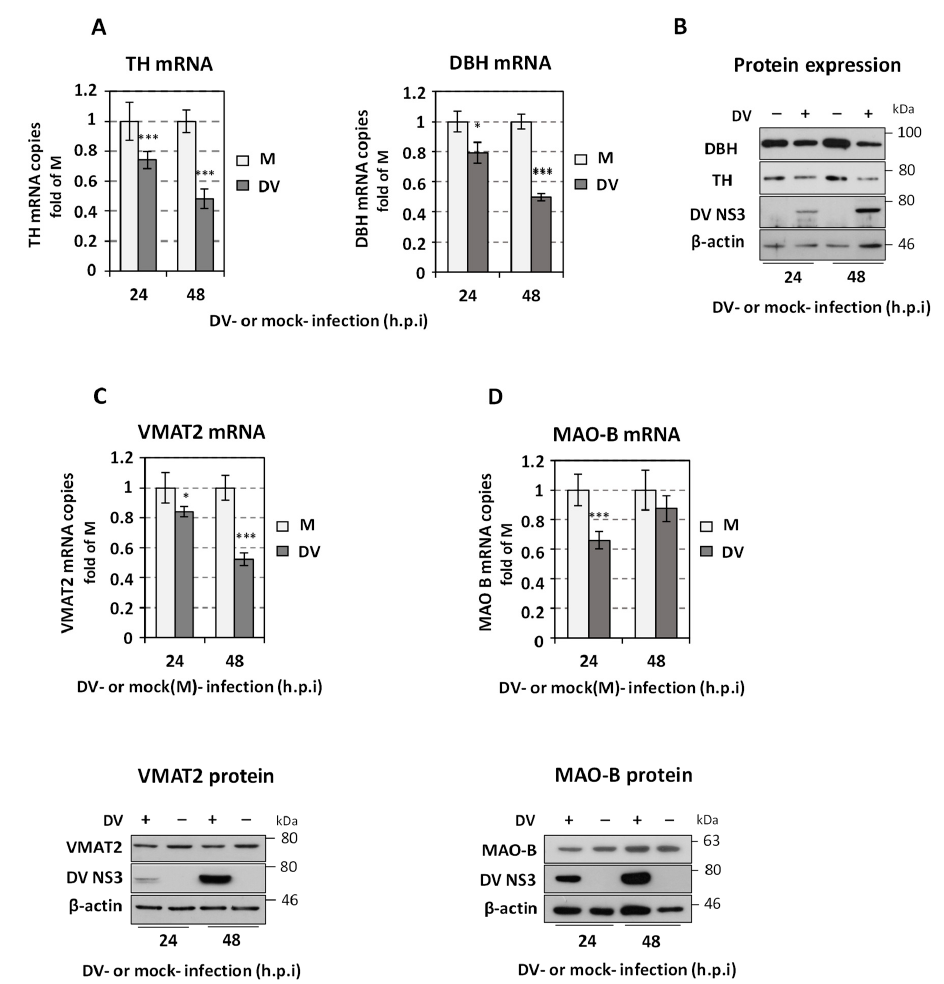
Figure 12. Effects of DV infection on the catecholamine pathway genes expression, except for DDC. After their inoculation with DV (MOI = 1), or mock infection (mock, M), Huh 7 cells were cultured for the displayed h.p.i. (( A , C , D ) upper panels) TH, DBH, VMAT2, and MAO-B mRNA levels were determined by RT-qPCR analysis and normalized to YWHAZ mRNA. Values are expressed relative to the ones derived from mock-infected (M) cells, at each time point. The mean values ± standard deviations from three biologically independent experiments in triplicate are featured. * p < 0.05, *** p < 0.001 vs. mock-infected cells. (( B – D ) lower panels) SDS-PAGE and immunoblot analysis were carried out in lysates of DV-infected (+) and mock-infected ( − ) cells with the use of antibodies de- tecting the proteins TH or DBH ( B ), VMAT2 ( C ), MAO-B ( D ) and β -actin (loading control). Anti- NS3 antibody was used to verify viral infection. An experiment that is representative of three inde- pendent repetitions is shown. 3.10. Catecholamine Biosynthesis/Metabolism Negatively Affects DV Replication in Other Cell Lines To confirm the bidirectional relationship between catecholamine biosynthesis/me- tabolism and DV replication in other cell lines, we used the immortalized human hepatic cell line IHH and the hematopoietic lineage cell line THP-1. THP-1 was selected as blood monocytes are among the prime targets of DV in vivo [88]. Firstly, we examined the effect